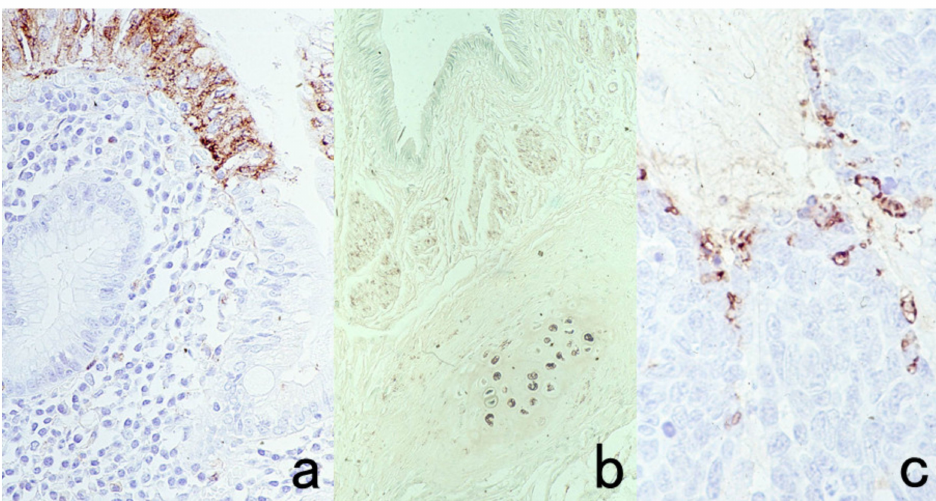
Figure 49. Cross-reactive antibodies against the carrier protein. Cholecystokinin (CCK) is a polypep- tide with 33 amino acid residues. The CCK antiserum was raised in a rabbit by using the Ascaris extract as carrier proteins. Ascaris protein-like (cross-reactive) immunoreactivities are observed in the gastric foveolar cells ( a ), smooth muscle cells and cartilage in the bronchial wall ( b ), and small cell lung carcinoma cells ( c ). One must not judge as CCK-producing small cell carcinoma of the lung. Note the vesicular cytoplasmic staining in panel ( c ) rather than fine granular staining.